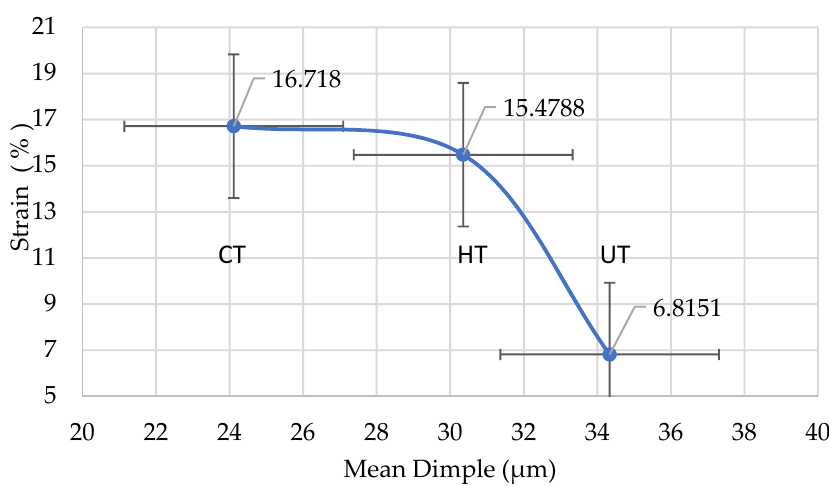
Figure 20. Mean dimple size vs % elongation.